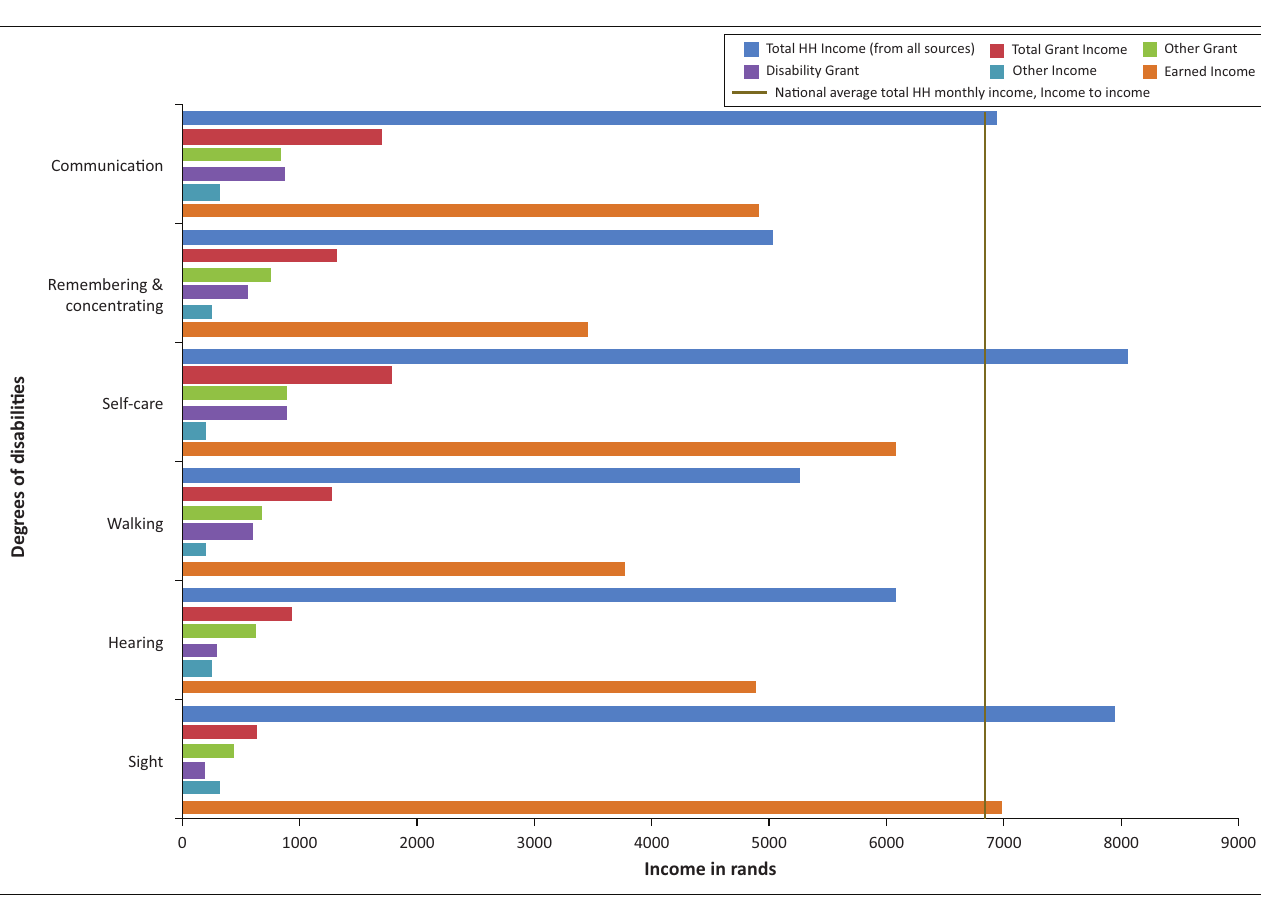
FIGURE 2: Average monthly household income, adults 15–59 years with all degrees of disabilities, by